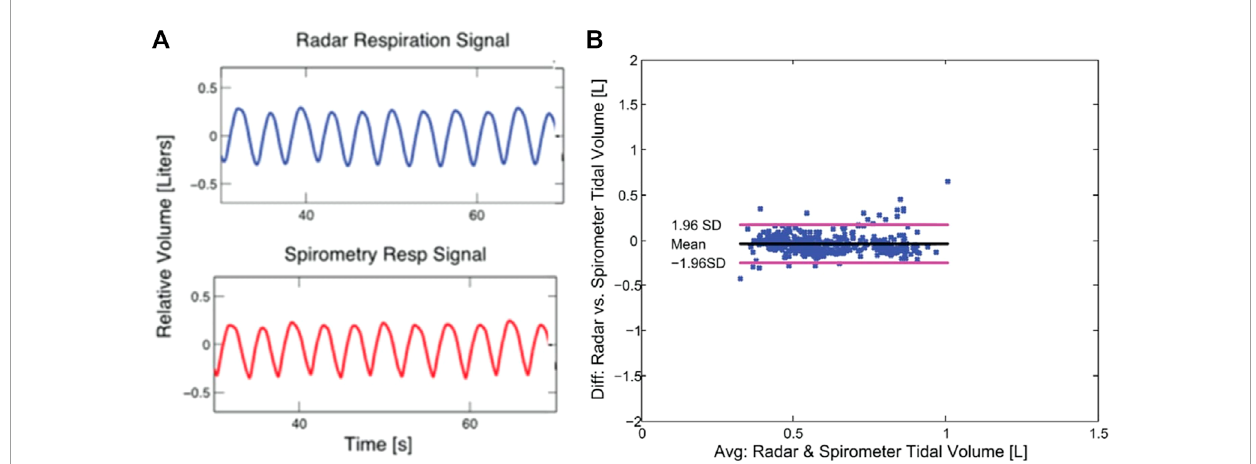
FIGURE 4 Tidal volume assessed using radar measured chest displacement. The demodulated radar time domain output matches the output of the spirometer (A) , and performance compared in a Bland-Altman analysis shows that the two instruments produce outputs of similar quality (B) (Massagram et al.,